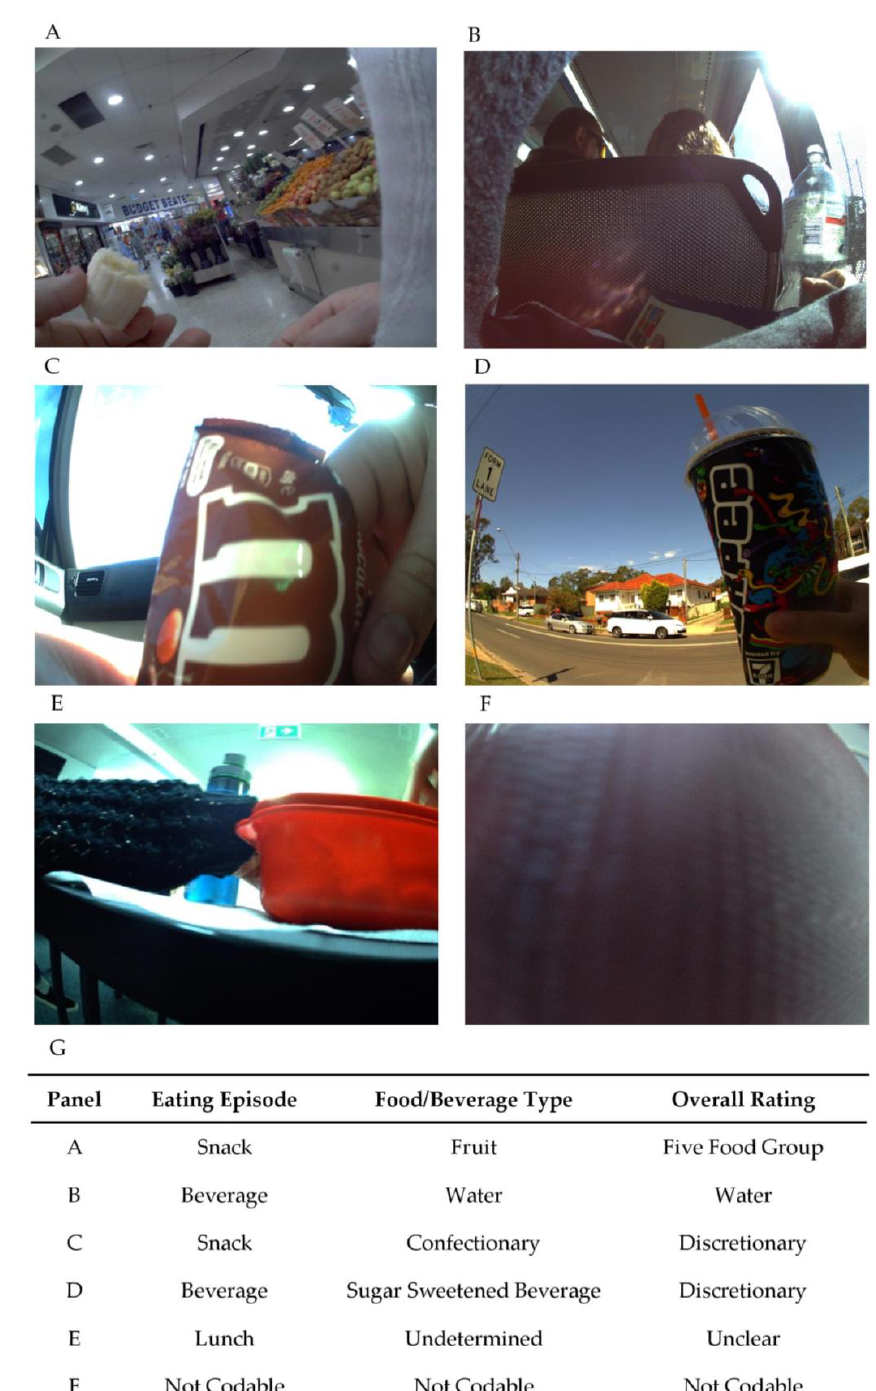
Figure 1. Flow diagram of the wearable camera study procedure and image coding protocol.